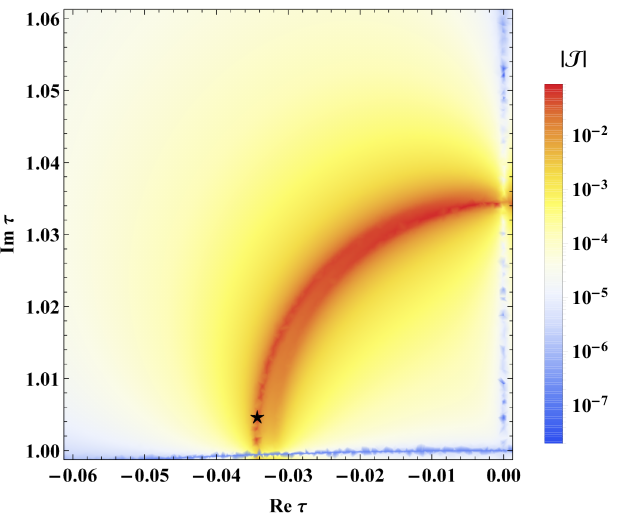
Figure 4 . The distribution of the absolute value of Jarlskog invariant |J | in the vicinity of τ = i , where = 1 . 456 and = − 0 . 350 are fixed. The black star corresponds to Re τ = − 0 . 0343 g g e e 2 3